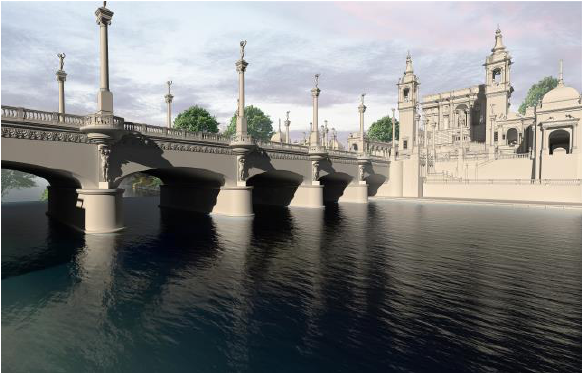
Figure 10. Final 3D model of the Monumental complex